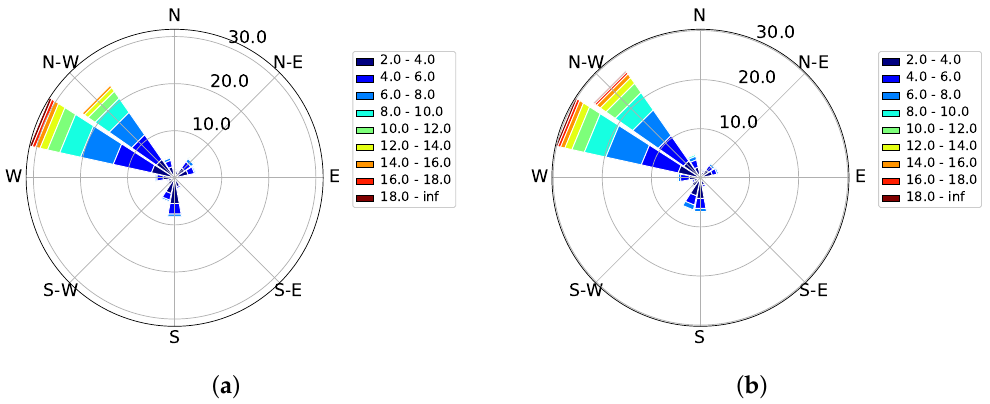
Figure 14. Wind rose showing wind speed and wind direction as measured at 57 m height. ( a ) Sonic anemometer; ( b ) V2